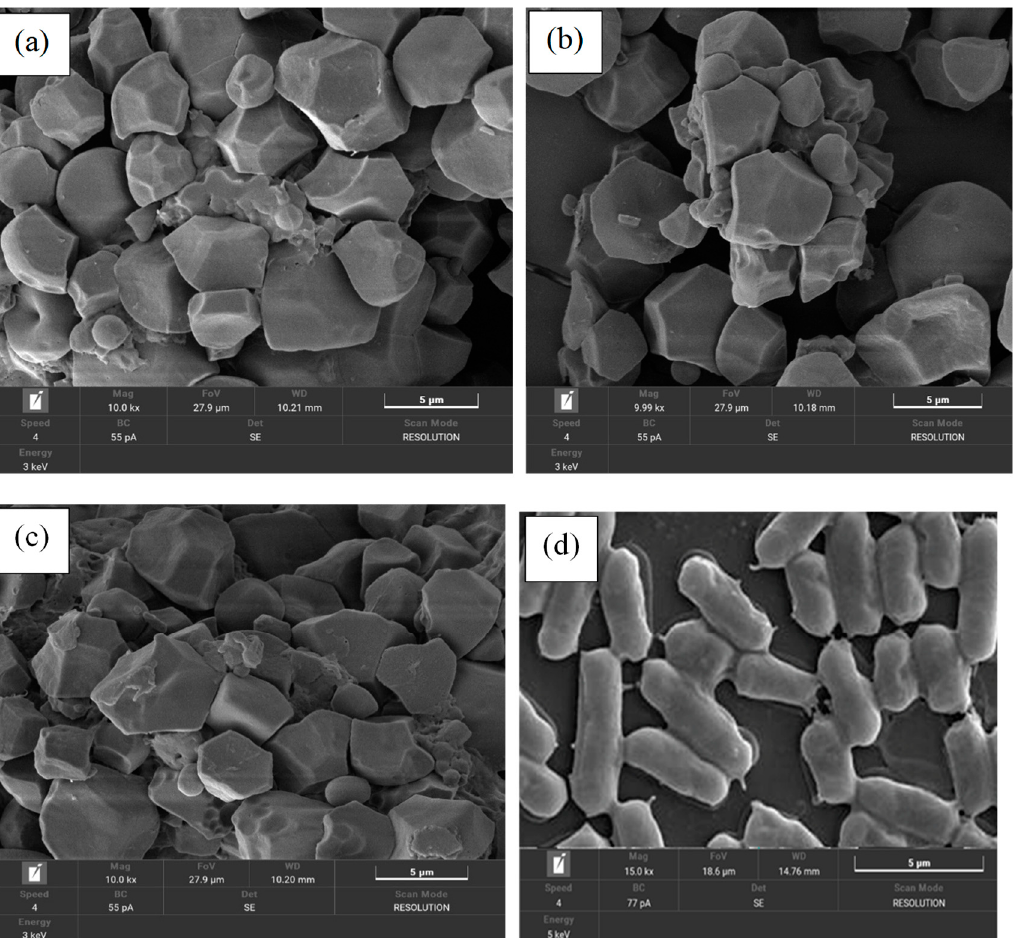
Figure 1. FE-SEM micrographs of the different encapsulations of the Lactobacillus species starter culture, with components of GRF combined with inulin at a ratio of 1:1 (% w / v ): ( a ) encapsulation of L. casei KKU-KK1, ( b ) encapsulation of L. pentosus KKU-KK2, ( c ) encapsulation of L. acidophilus KKU-KK1, and ( d ) un-encapsulation of mixed Lactobacillus sp. cell culture, respectively.